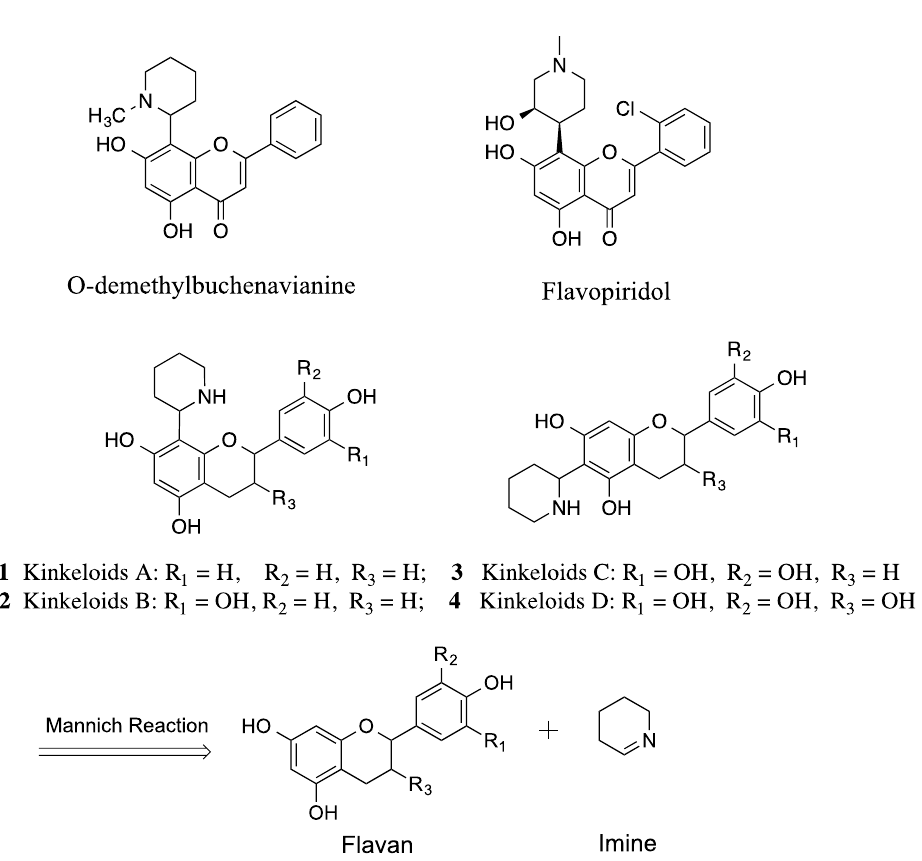
Figure 1. Kinkeloids and retrosynthetic analysis.